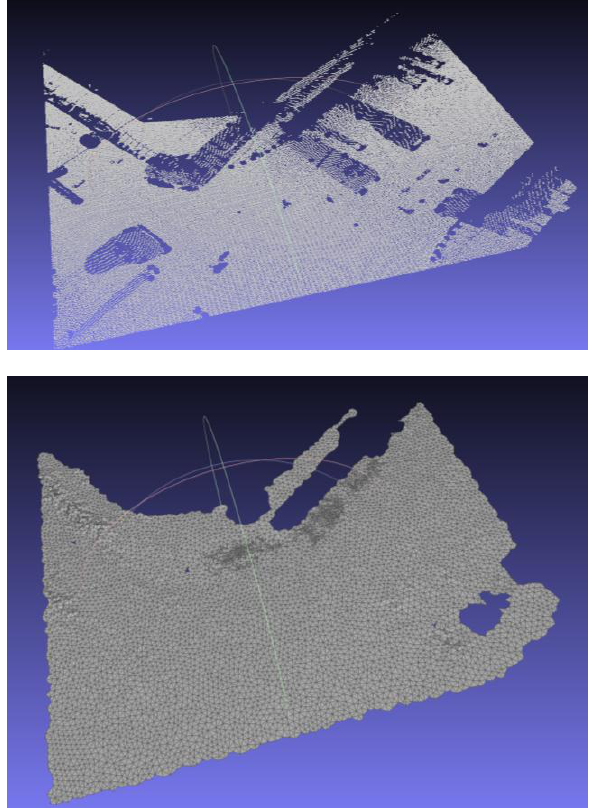
Figure 4. MMS point cloud representing road (top) & after holes filling